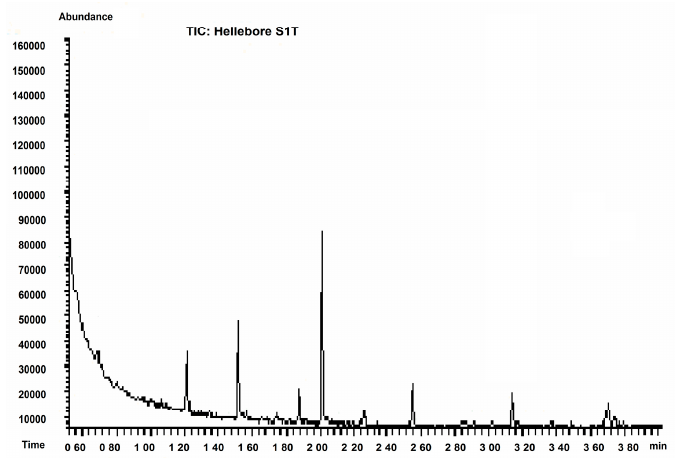
Figure 2. Cont. Figure 2. Cont.